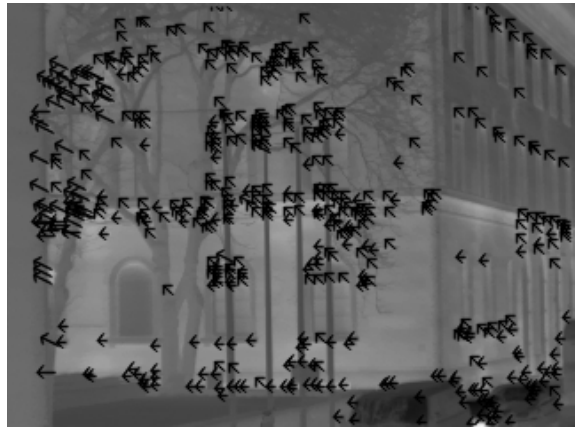
Figure 1. IR image with selected SIFT features, that have cor- respondences in the following image. Arrows show the moving direction of the